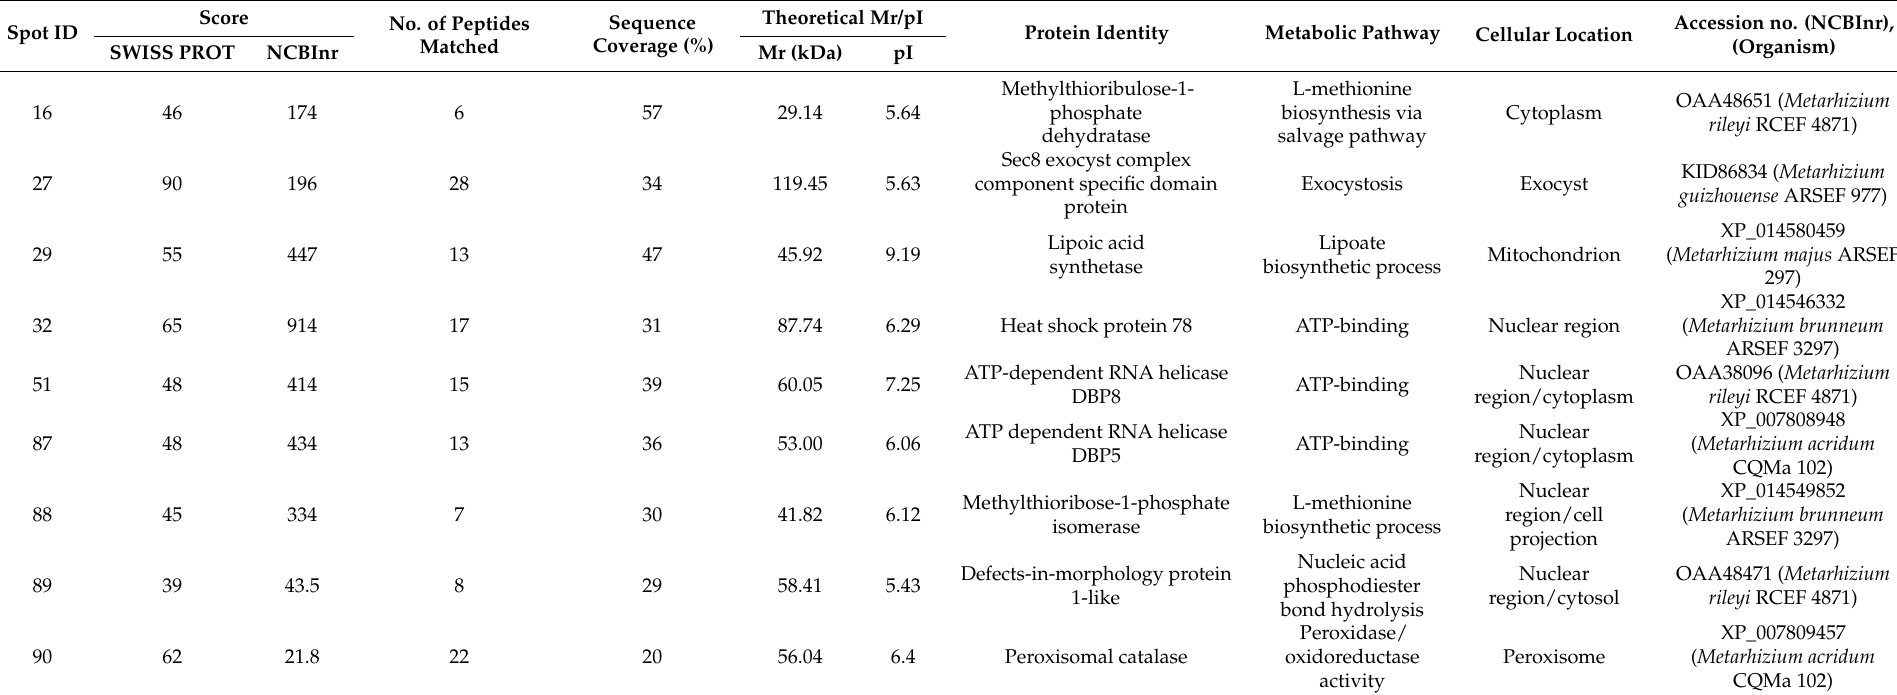
Table 2. MALDI-TOF mass fingerprinting data of the nine differentially expressed proteins isolated from Metarhizium anisopliae infecting Coptotermes curvignathus . Proteome changes in the infecting fungus were compared in a time-line post-inoculation (PI) experiment to control proteins, extracted from 2D electrophoresis gels prior to